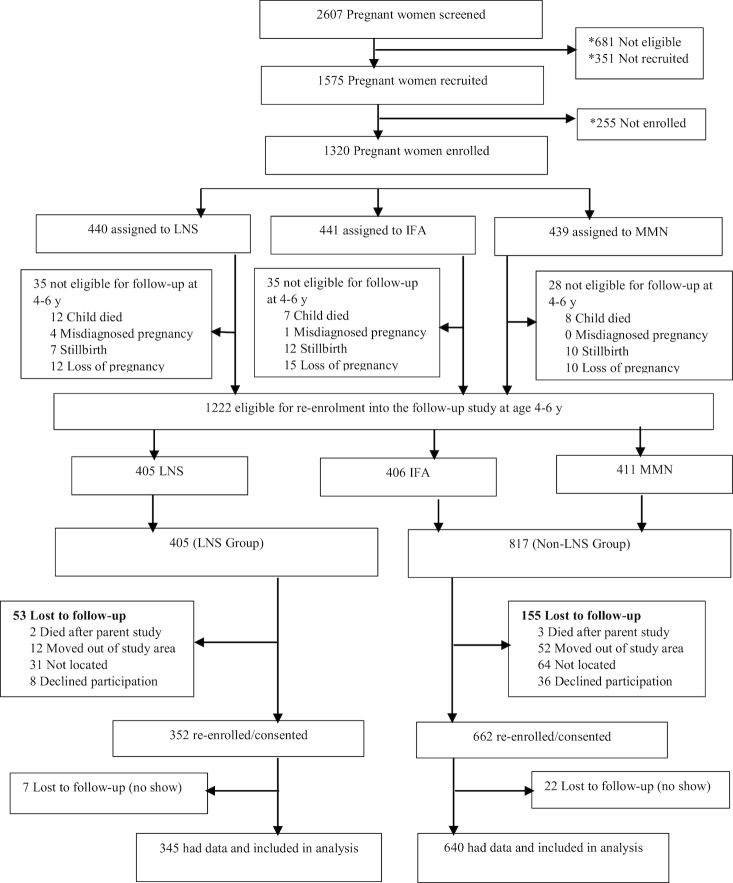
Study profile. IFA, iron and folic acid; LNS, lipid-based nutrient supplement; MMN, multiple micronutrients. LNS group, women received 20 g LNS daily during pregnancy and for 6 mo postpartum. Infants received 20 g LNS daily from 6–18 mo of age; Non-LNS group, women received either IFA during pregnancy and placebo for 6 mo postpartum or MMN capsules during pregnancy and for 6 mo postpartum. Infants did not receive any supplement. *Details reported in (29).